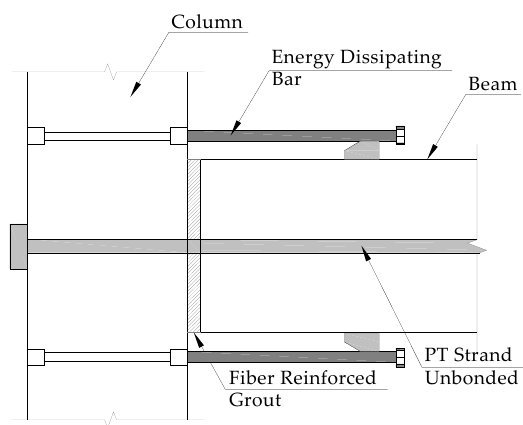
Figure 26. Proposed precast post-tensioned beam–column connection [50]. Geng et al. (2020) [24] proposed a new hybrid connection with a damper, as shown in Figure 27. The connection performed well with regard to seismic loads. The energy dissipators were placed outside the beam on the sides.